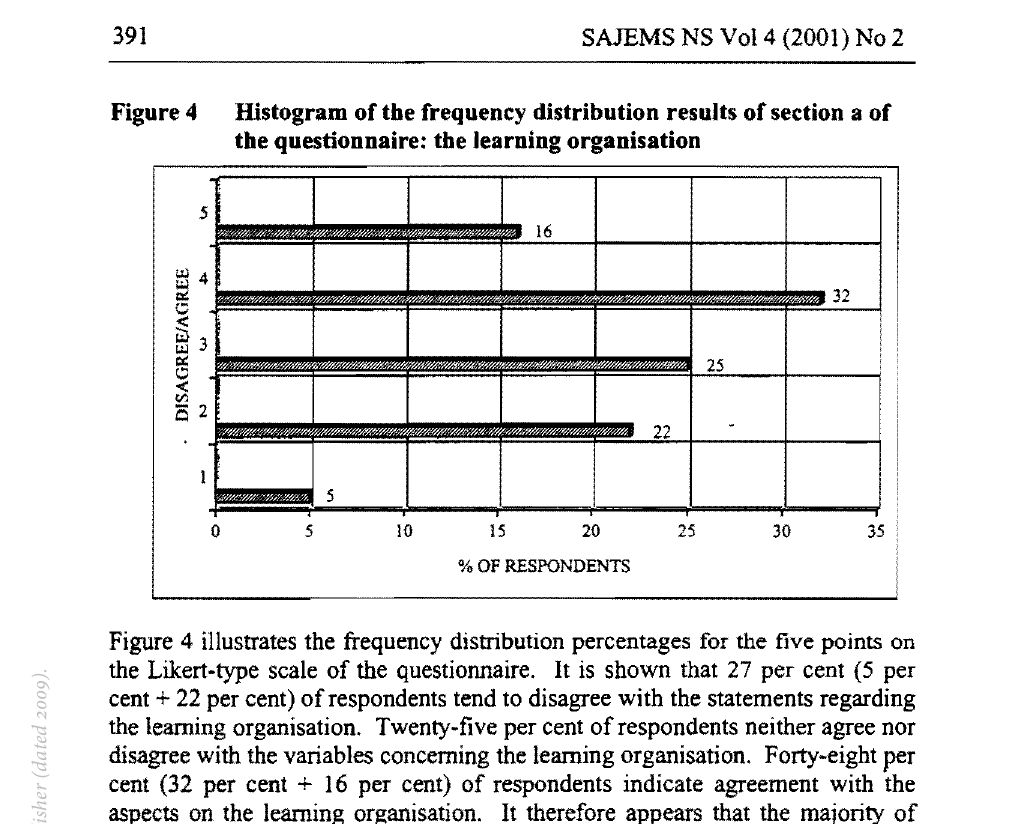
Figure 4 Histogram of tbe frequency distribution results of section a of tbe questionnaire: tbe Jearning